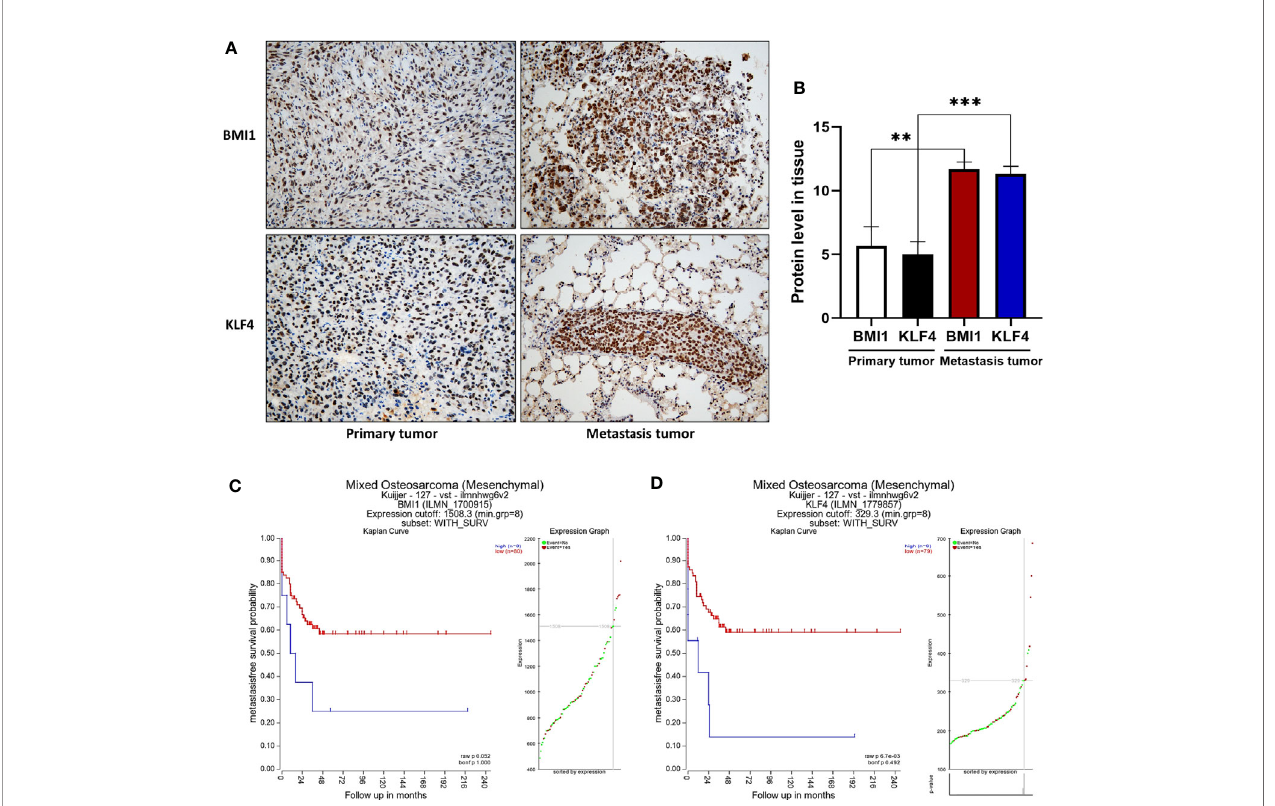
FIGURE 6 | Positive BMI1 and KLF4 expression are associated with OS metastasis, and predicted a short survival time in patients. (A) Immunohistochemistry. The mouse OS cell xenografts and lung tissues were resected from the nude mice and subjected to tissue processing, embedding, sectioning, and immunohistochemistry (magni fi cation, ×40). (B) The graph of the quanti fi ed data of immunohistochemical staining of BMI1 and KLF4. (** p < 0.01; *** p < 0.001; n = 3). (C, D) Kaplan-Meier analyses. BMI1 and KLF4 expression in OS was analyzed to predict the prognosis of OS patients by using Kaplan-Meier method on R2: Genomics Analysis and Visualization Platform. ( p > 0.05; ** p < 0.01; C, D ). The data were expressed as the mean ±